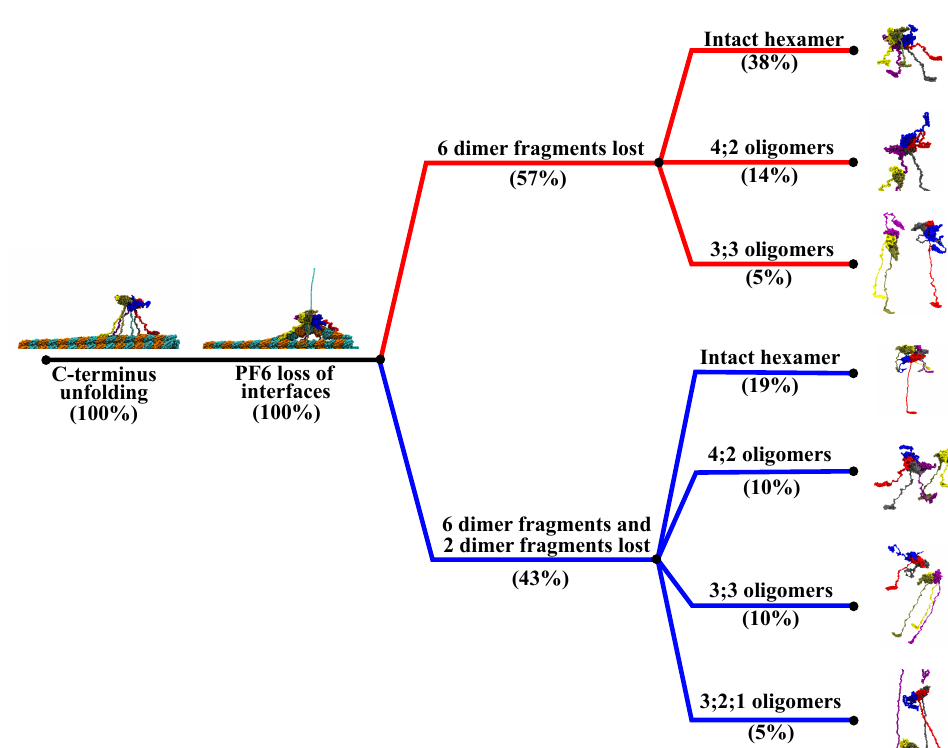
Figure 4. Severing pathways found for the unfoldase severing action of the full spastin machine with free MIT domains on MT8 lattice for all the probed interaction strengths between the MIT domains and the MT lattice. Descriptions and percentage of event occurrences (out of the 21 trajectories) are provided for each main event of a severing mechanism. Colors are used to separate major diverging